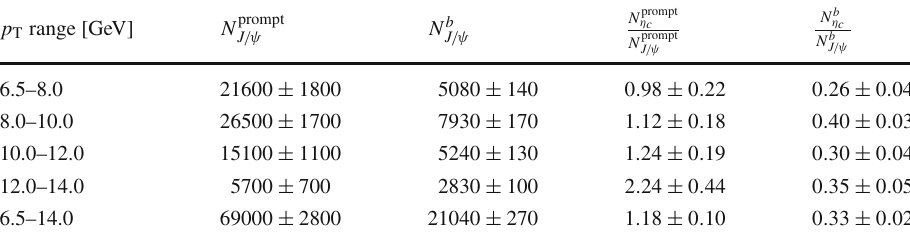
Table 1 Yield of J /ψ mesons